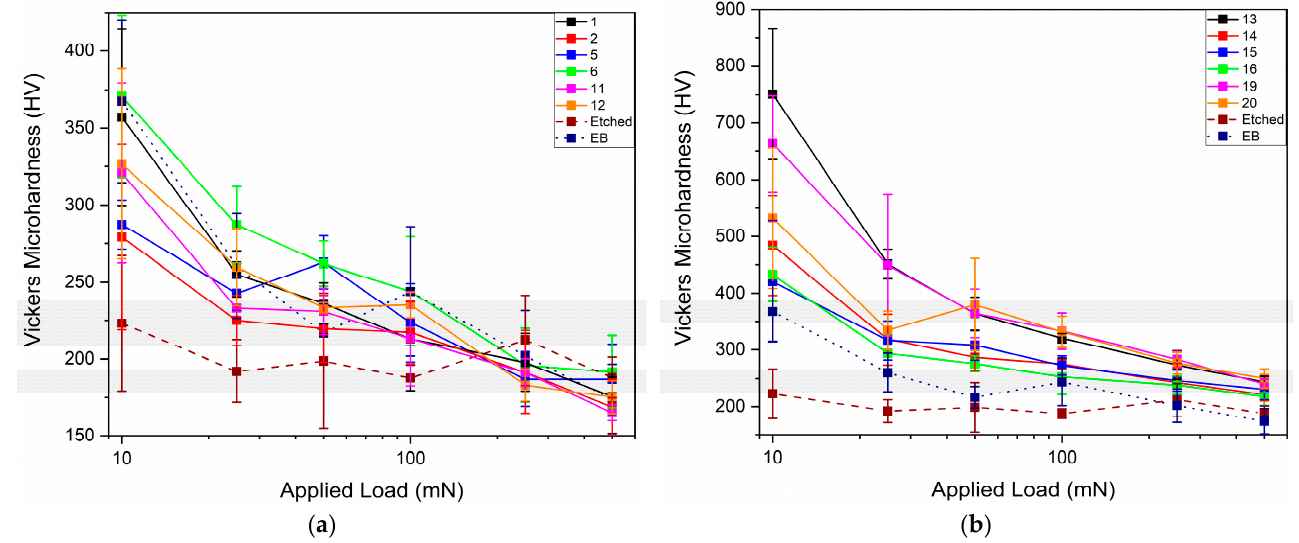
Figure 13. Vickers microhardness as a function of applied load for samples of the first ( a ) and second set ( b ), respectively.